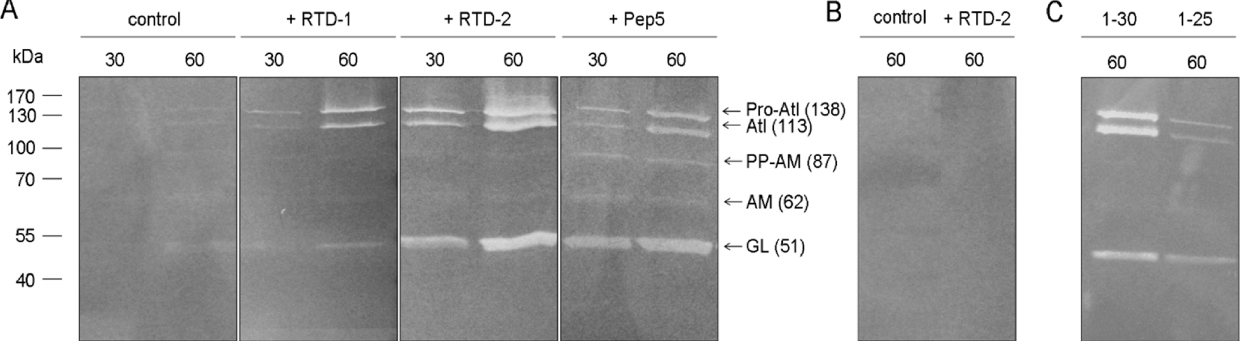
Figure 5. Detection of cell wall lytic enzymes in the supernatant of RTD-treated cells. (A) S. aureus SG511-Berlin was exposed to 10× MIC of RTDs or Pep5, respectively, for 30 and 60 min. Equal amounts of the concentrated culture supernatant (containing autolysins released from the cell surface) were separated on a 12% SDS-PAGE containing heat-inactivated M. luteus cells as substrate. Bands represent cell lysis zones; (B) S. aureus SA113 ∆atl treated for 60 min with 10× MIC RTD-2; (C) S. aureus SG511-Berlin treated for 60 min with two RTD-1 variants (RTD-1-30 and RTD-1-25) which differ in the distribution of positively charged residues. All bands represent differently processed forms of the autolysin Atl as in the atl deletion mutant (∆atl) the corresponding autolysis bands were missing (B). Pro-Atl: Atl with full-length propeptide, Atl: amidase and glucosaminidase,